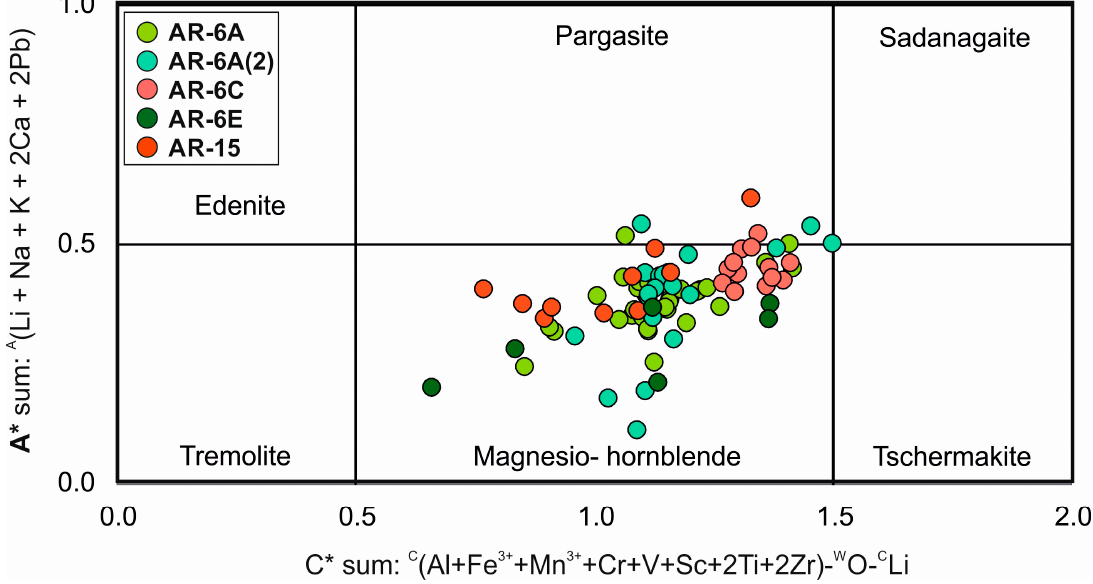
Figure 5. Ca-amphiboles chemistry from the ortoamphibolites from the Aravalli. Plot of the EMPA data in the calcic amphibole classification diagram [23]. A* A (Li+ Na + K + 2Ca + 2Pb); C* C (Al + Fe 3+ + Mn 3+ + Cr + V + Sc + 2Ti + 2Zr) − W O − C Li.